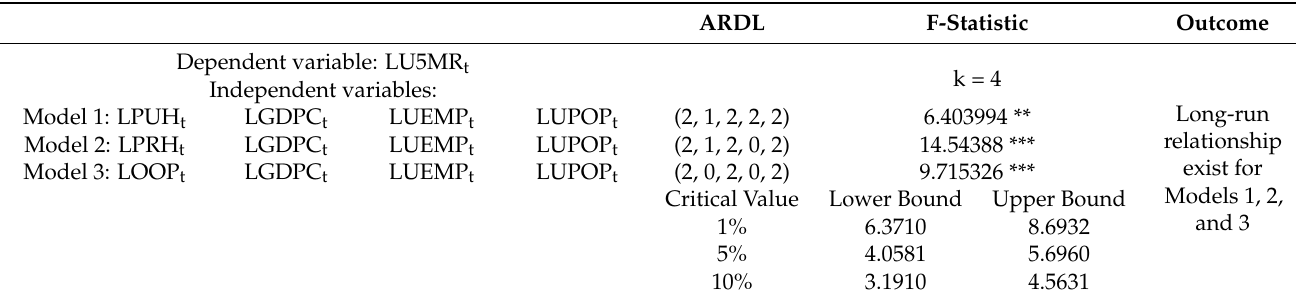
Table 3. Bound test (cointegration)